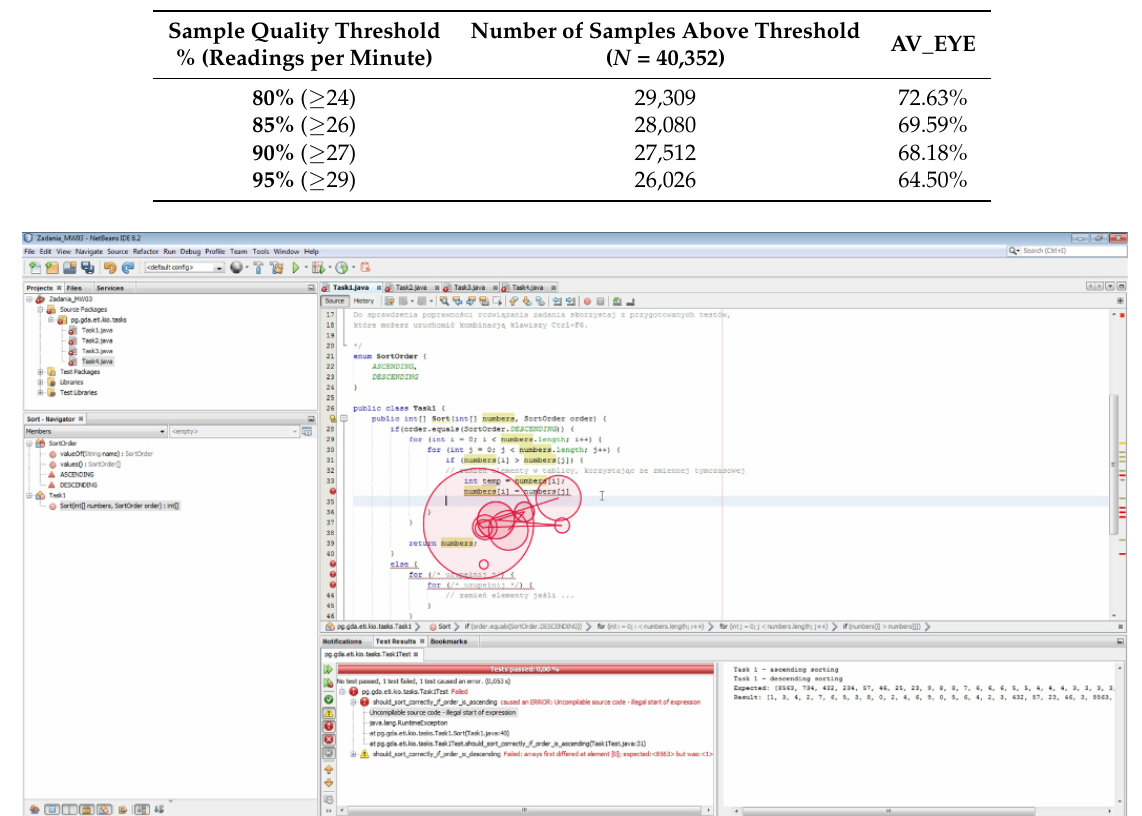
Table 1. Eye-tracker sample quality threshold and corresponding availability.